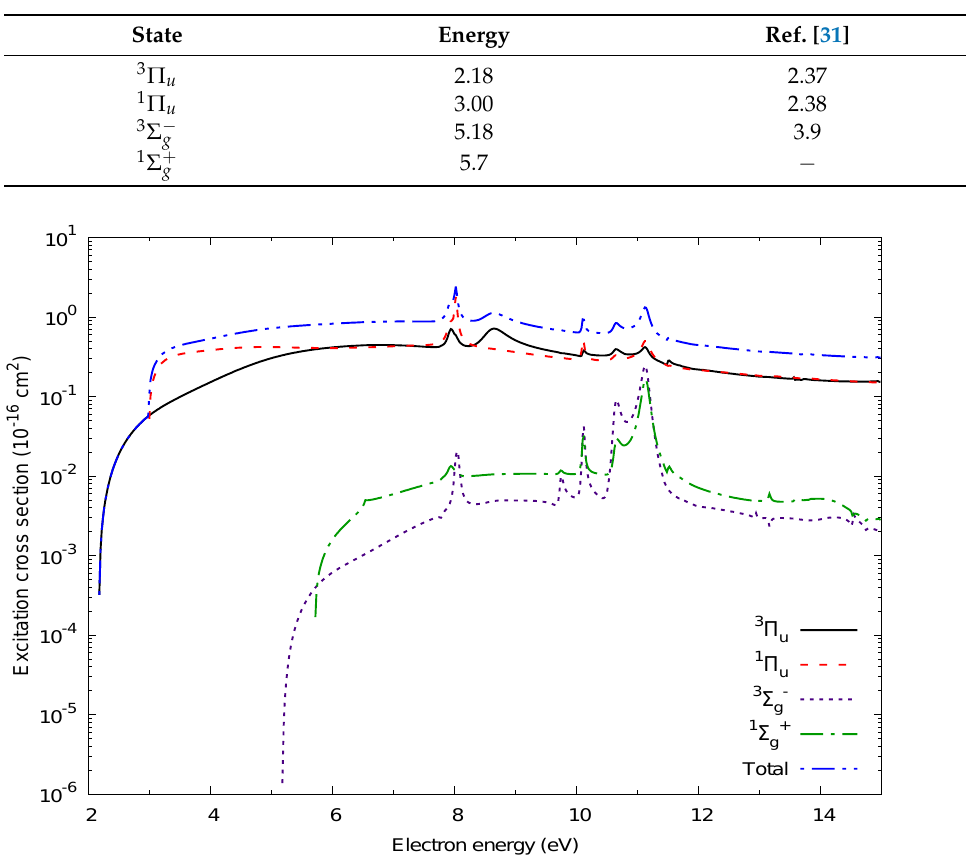
Table 4. Vertical excitation energies (eV) from the ground state.